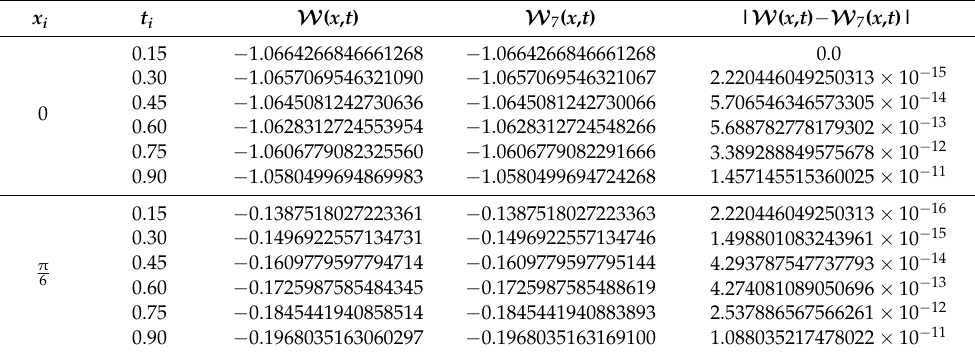
Table 4. Numerical results for Example 2 at